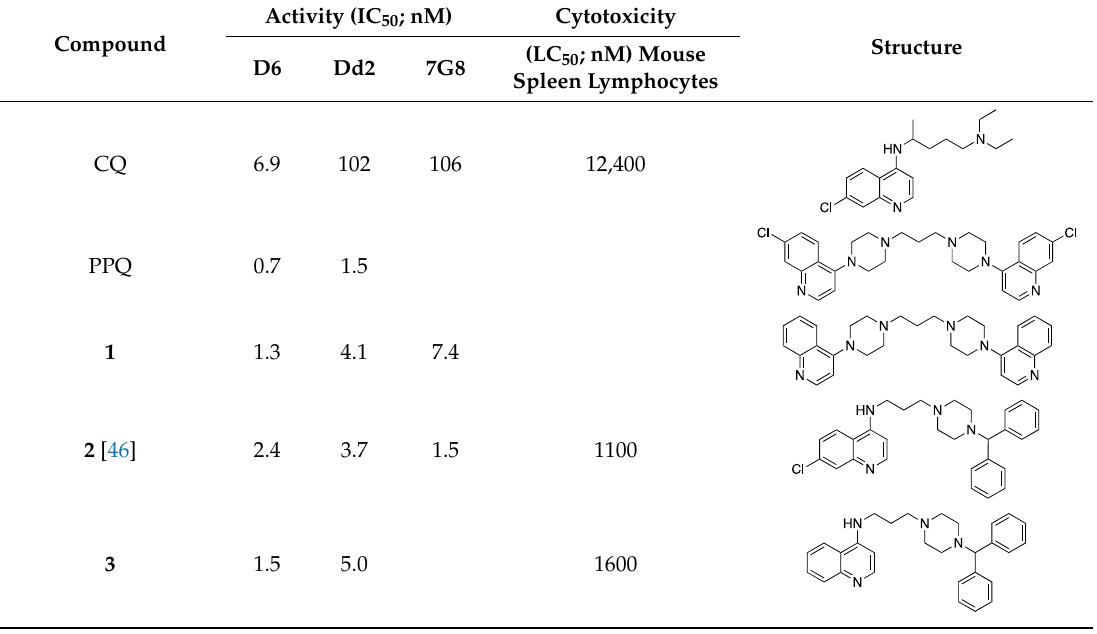
Table 1. In vitro antiplasmodial activities of bisquinoline and related compounds.